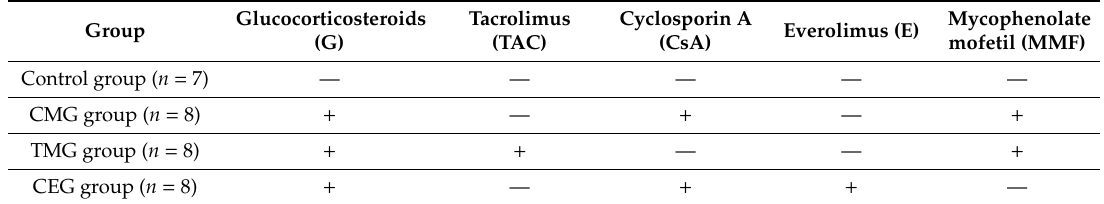
Table 1. The study